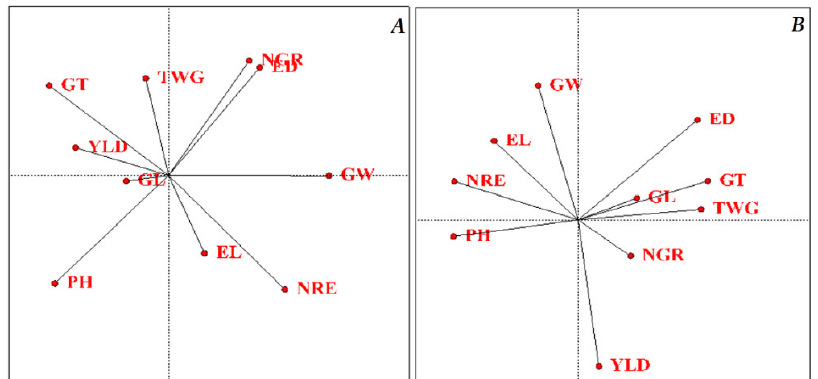
Figure 1. Correlation diagram between the studied traits under normal conditions and water stress.